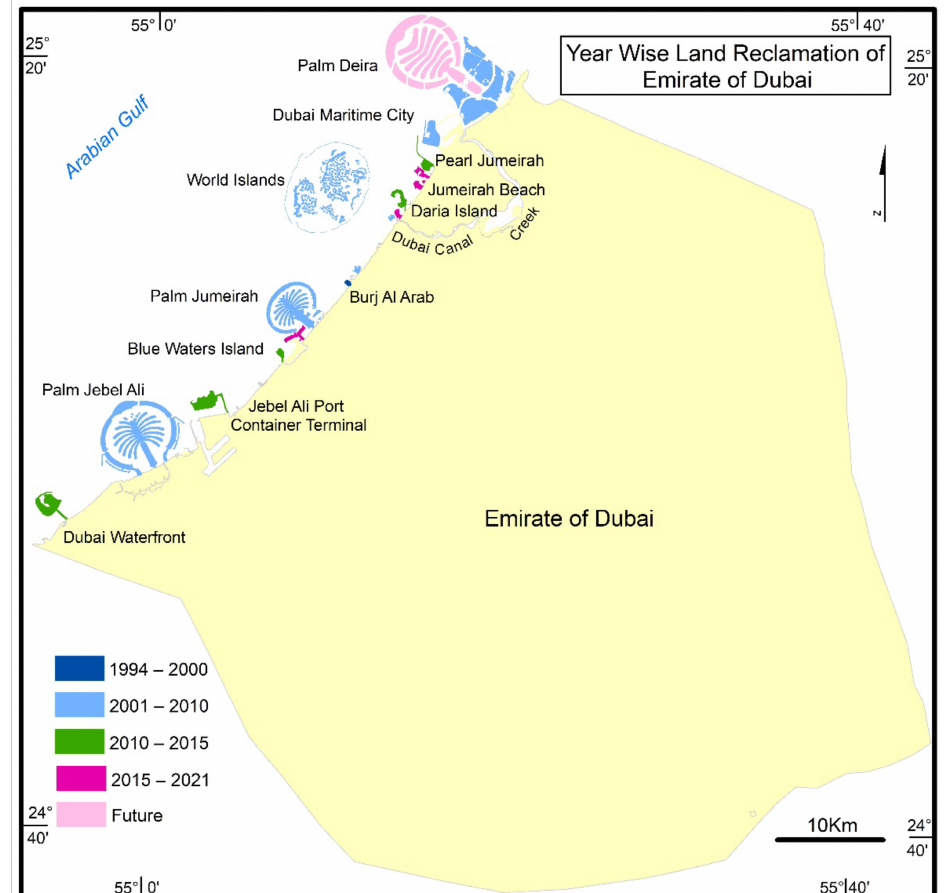
Figure 8. Year-wise land reclamation of